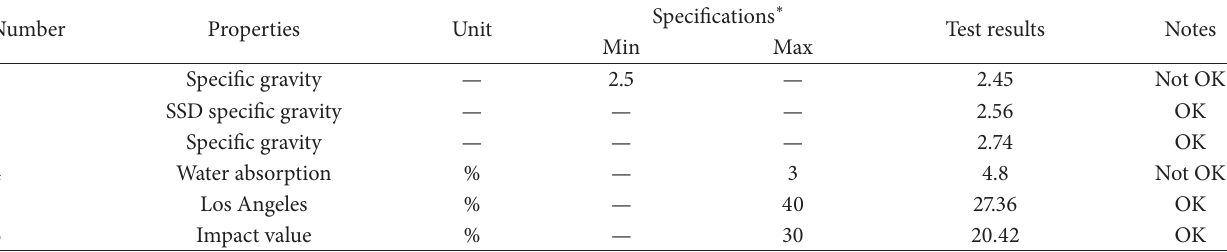
Table 5: Properties of concrete waste aggregate.